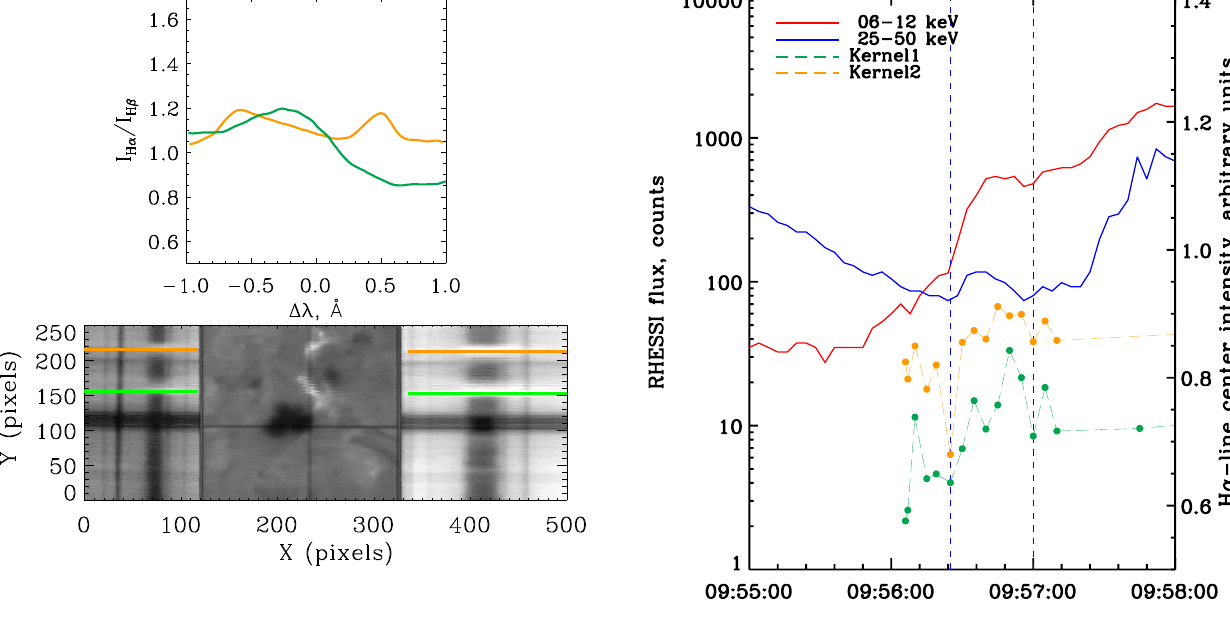
Fig. 7. Temporal evolution of hard X-ray flux from RHESSI and the H α -line center intensity of the kernels. The vertical dashed lines mark the beginning and end of the HXR